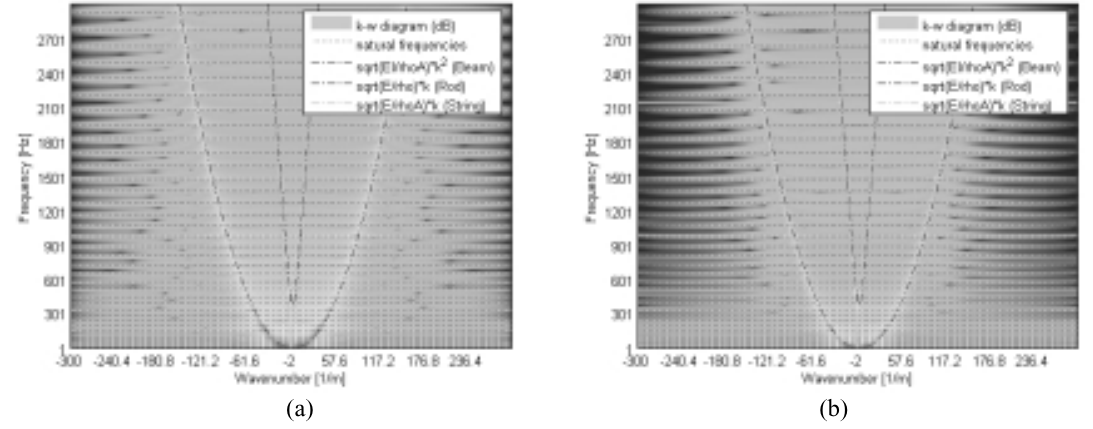
Fig. 4. Diagrams k - ω with radial excitation (a) and with tangential excitation (b) and P int = 0.